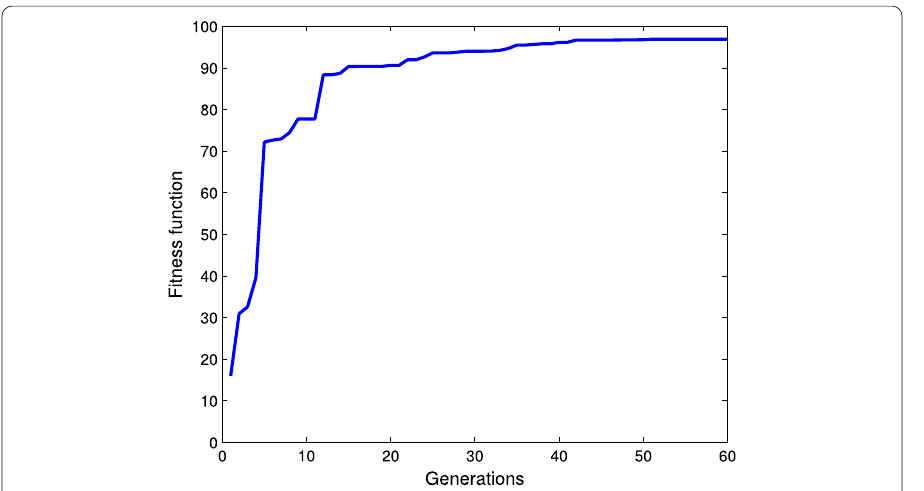
Fig. 11 The fitness function with generations for multiple